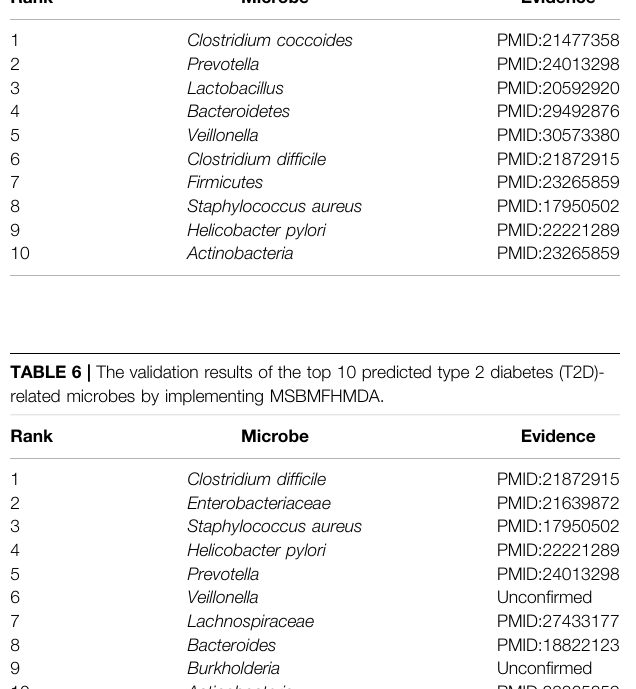
TABLE 5 | The validation results of the top 10 predicted in fl ammatory bowel disease (IBD)-related microbes by implementing MSBMFHMDA. Rank Microbe